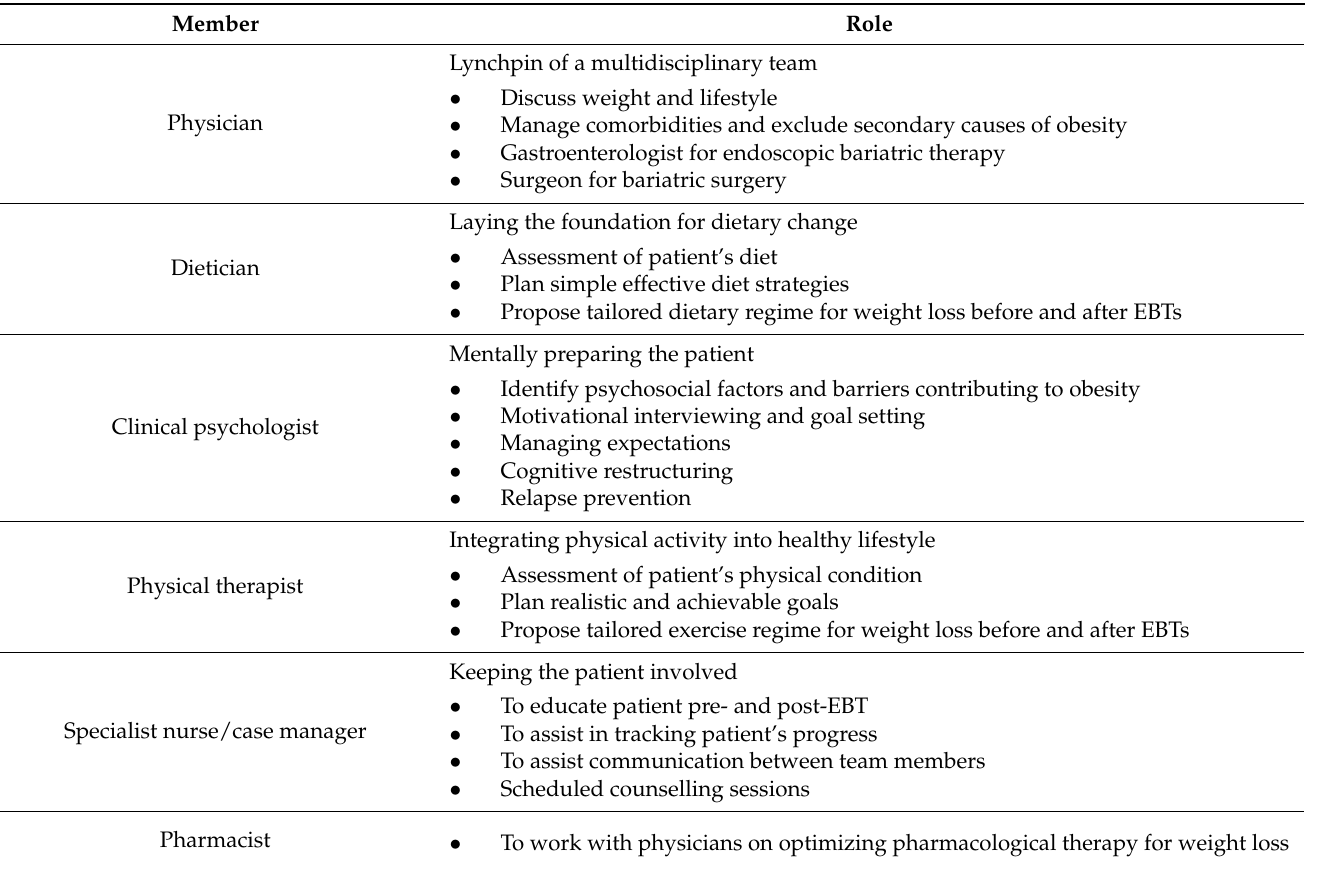
Table 2. Multidisciplinary care team and their role in endoscopic bariatric